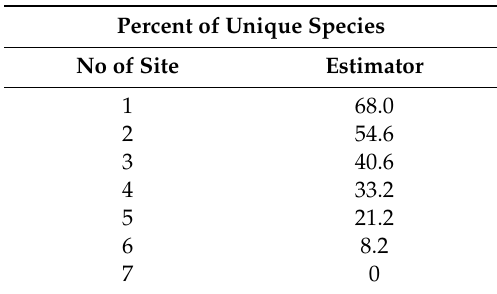
Table 5. Unique species estimator in the algae and cyanobacteria communities in studied sites of the bogs of the Ershov oil field in the Vakh River basin of the